Question: Give a one-sentence summary of this figure.
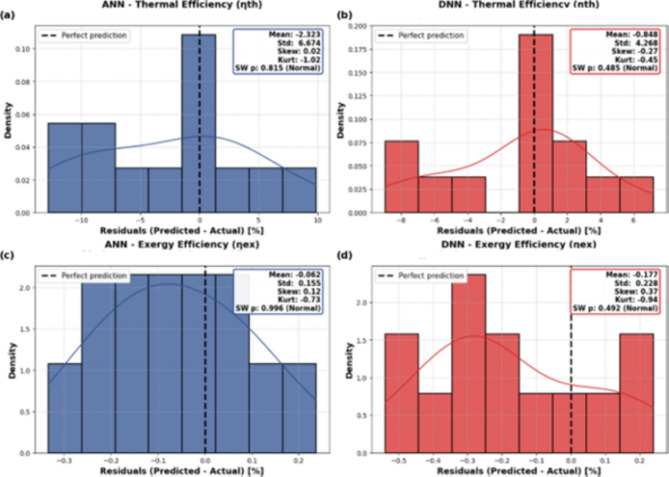
Answer: The residual histograms for ANN and DNN models.